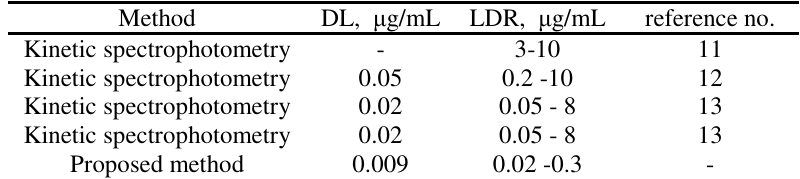
Table 4. Comparison of kinetic spectrophotometry methods for the determination